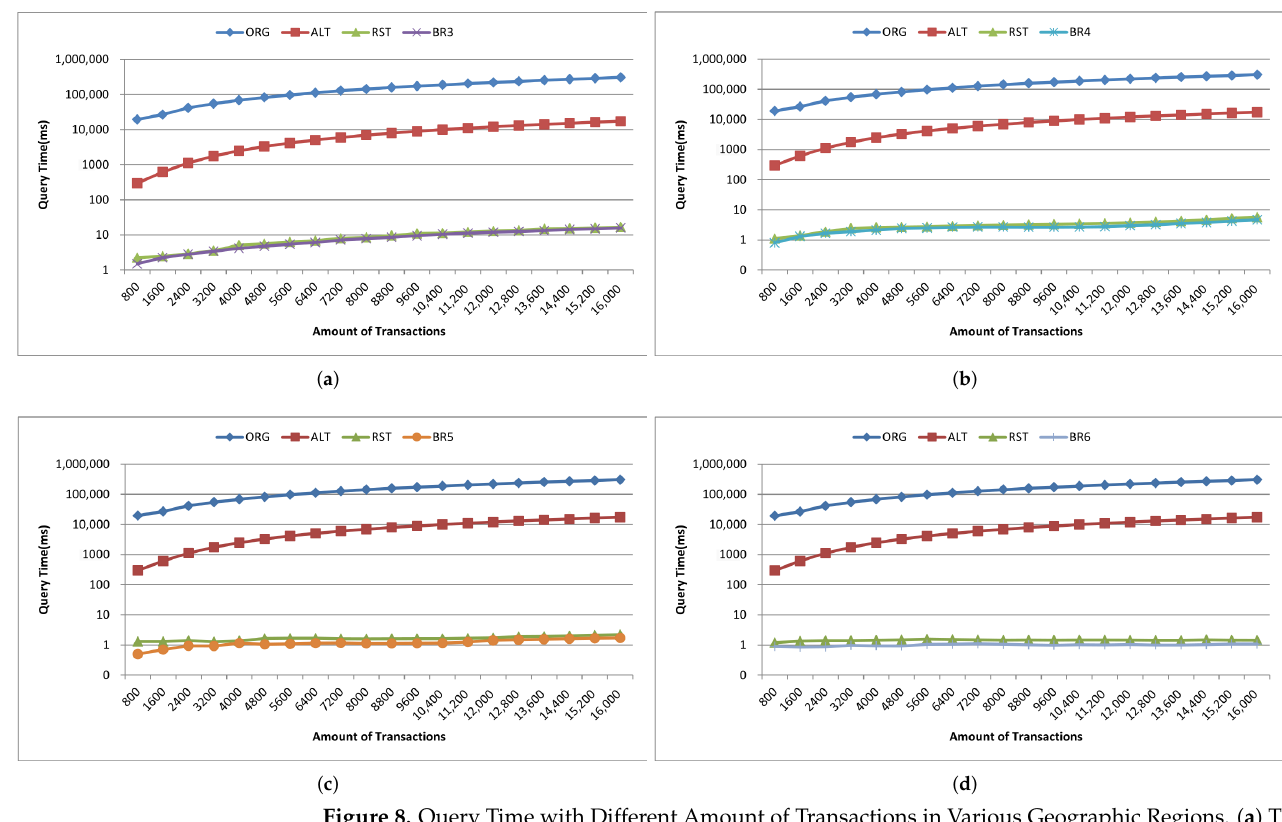
Figure 8. Query Time with Different Amount of Transactions in Various Geographic Regions. ( a ) The query range is geographic region of the 3-byte Geohash encoding. ( b ) The query range is geographic region of the 4-byte Geohash encoding. ( c ) The query range is geographic region of the 5-byte Geohash encoding. ( d ) The query range is geographic region of the 6-byte Geohash